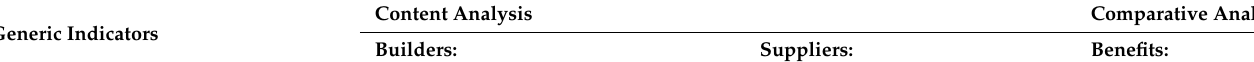
Table 3. Conferred Collective Off-site Prefabrication Benefits and